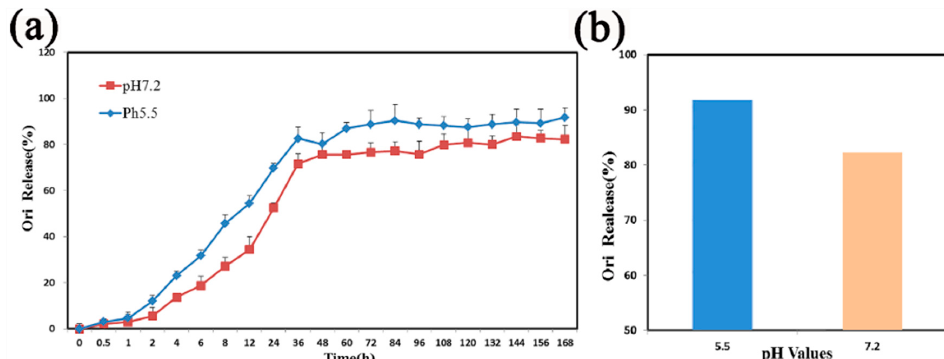
Figure 5. ( a ) The release curve of Ori@MIL-53(Fe) under different pH values. ( b ) The total release of Ori.